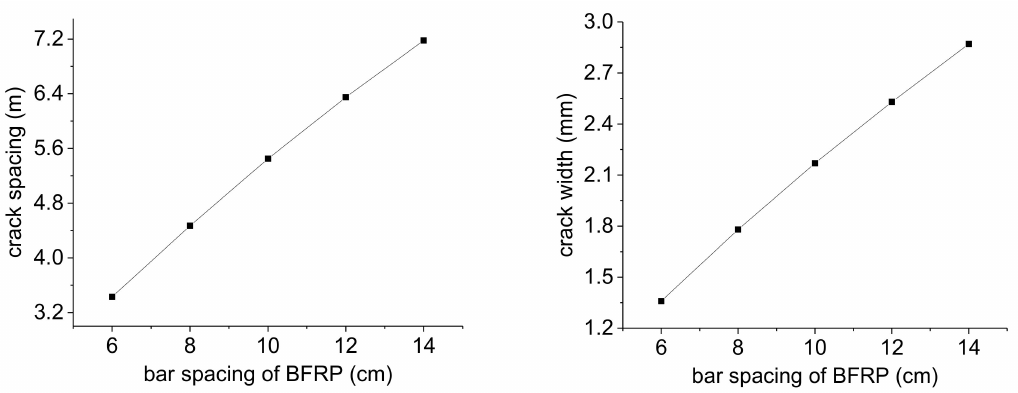
Figure 8. Impact of BFRP spacing on the crack spacing ( left ) and crack width ( right ) of CRCP with BFRP bars.